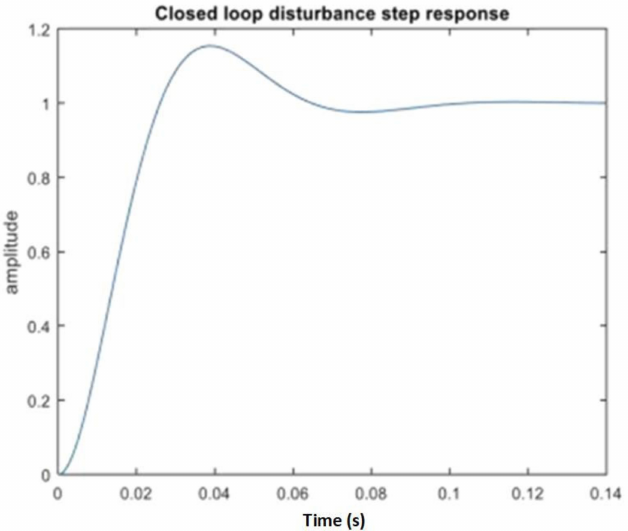
Figure 11. Closed loop response of the machining bed to a step